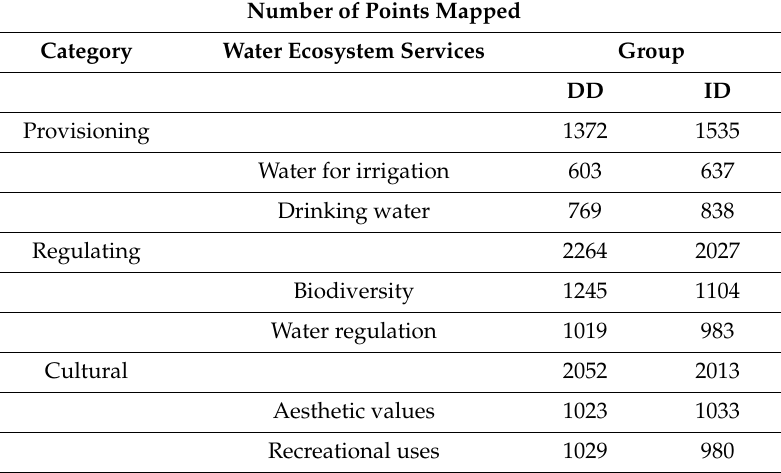
Table 3. Number of points mapped for each water ecosystem service category and unit by stakeholders directly and indirectly dependent on these services (directly dependent (DD) and indirectly dependent (ID)